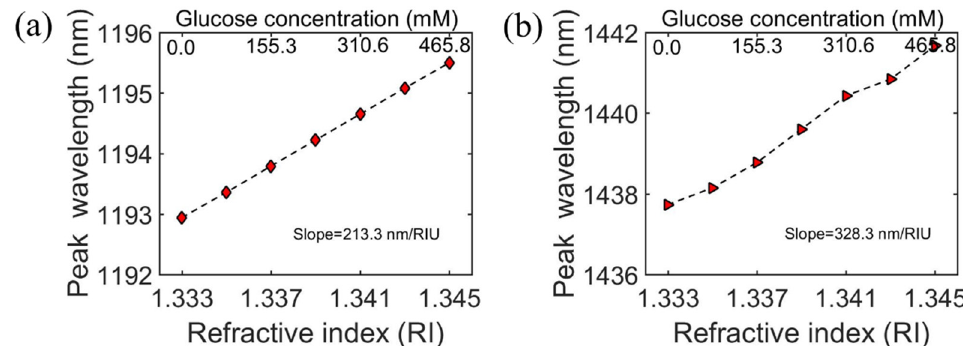
Figure 9. The wavelength absorption peak occurs as a function of the surrounding refractive index and exhibits different sensing performances for the ( a ) antisymmetric mode and ( b ) ENZ mode.